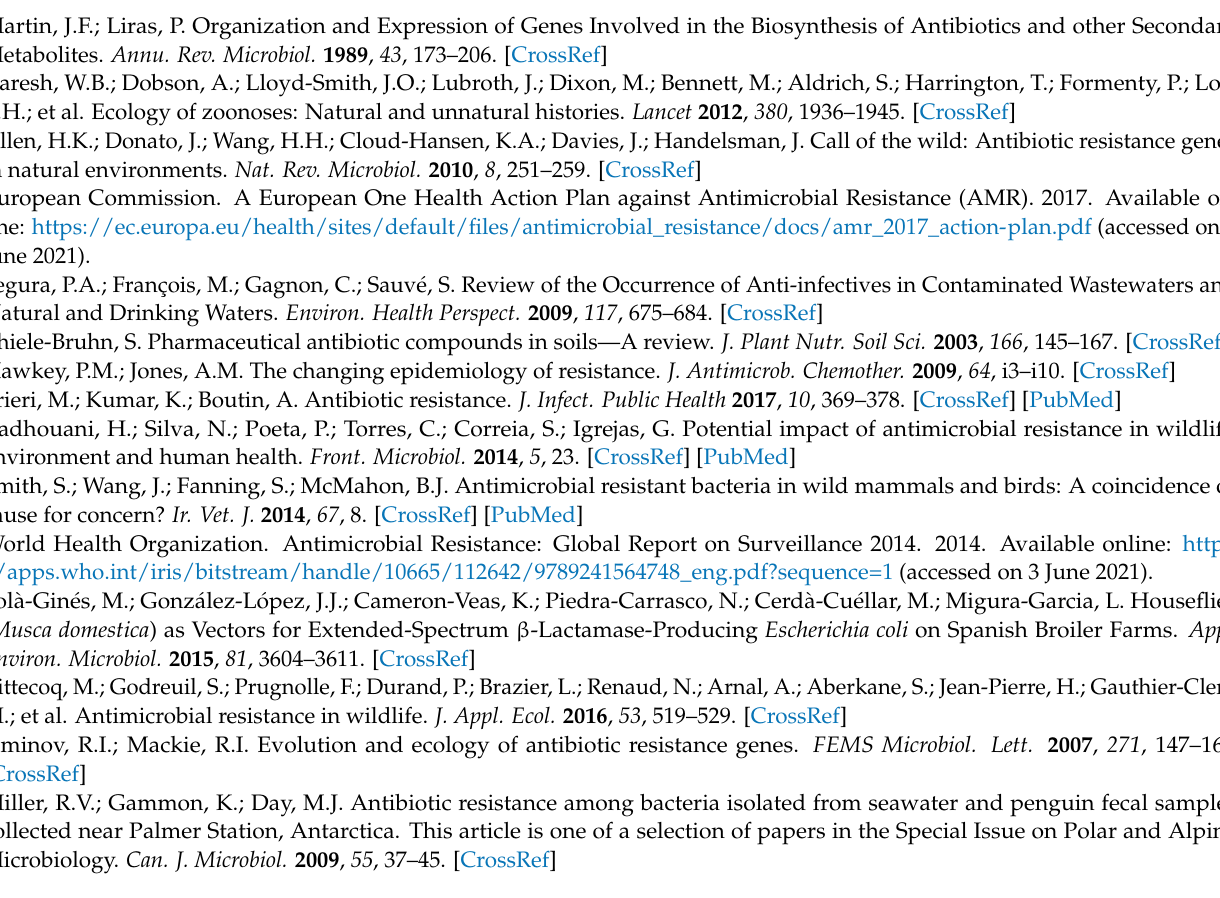
Table S2: MIC distribution frequencies of Mannheimia haemolytica isolates, Table S3: MIC distribution frequencies of Biberstenia trehalosi isolates from Pyrenean